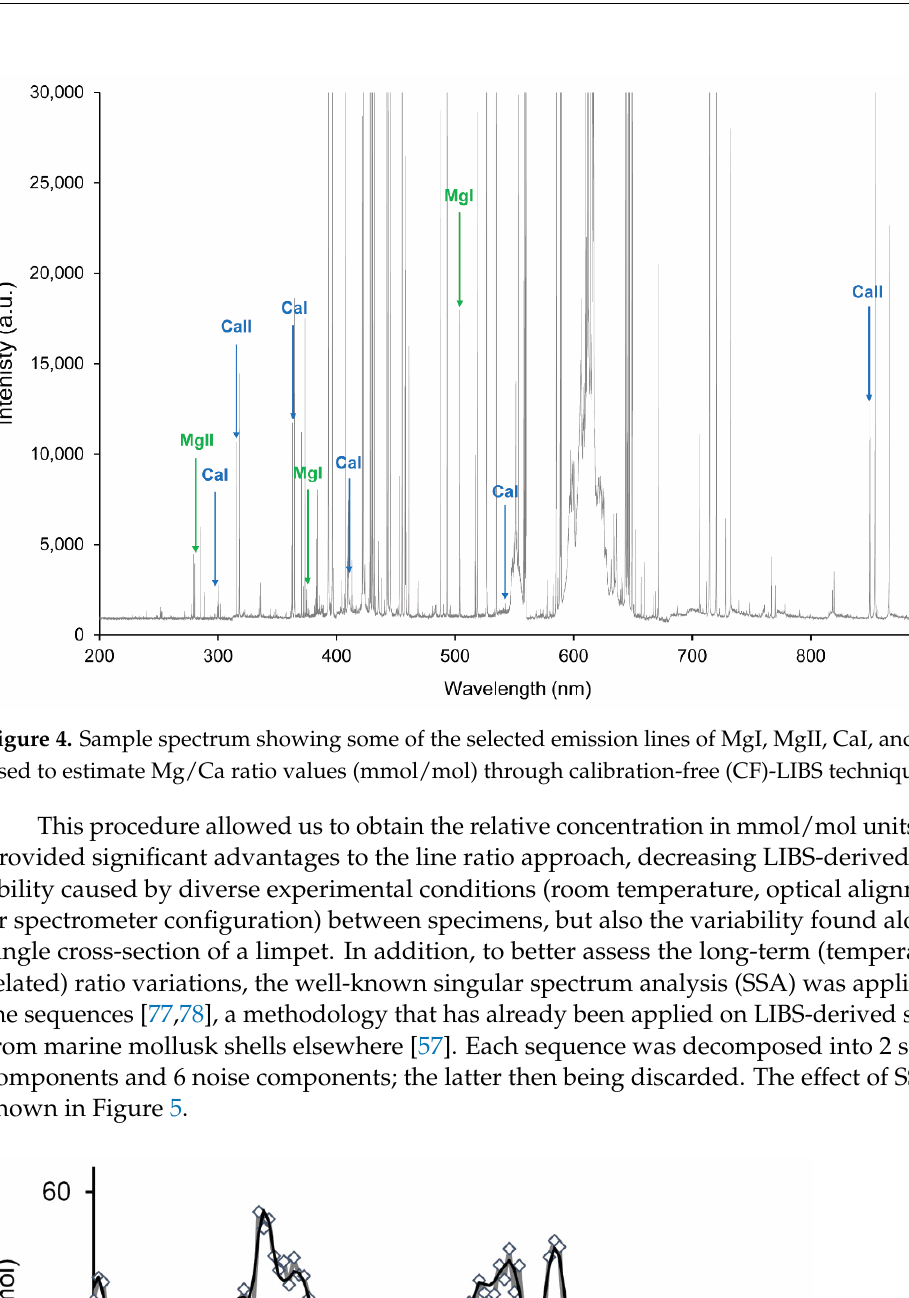
Figure 5. Mg/Ca ratios obtained with the proposed CF-LIBS procedure (grey line) and the same data postprocessed with the SSA algorithm (black line).